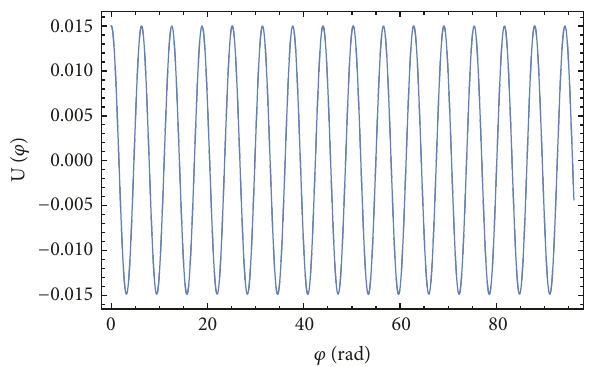
Figure 3: Comparison of the numerical solution 𝑈(𝜑) of (123), describing the motion of a photon in Schwarzschild geometry (solid curve), and of its truncated power series solution obtained by the Laplace-Adomian Decomposition Method, given by (129) (dashed curve), for 𝑎 = 0.015 .